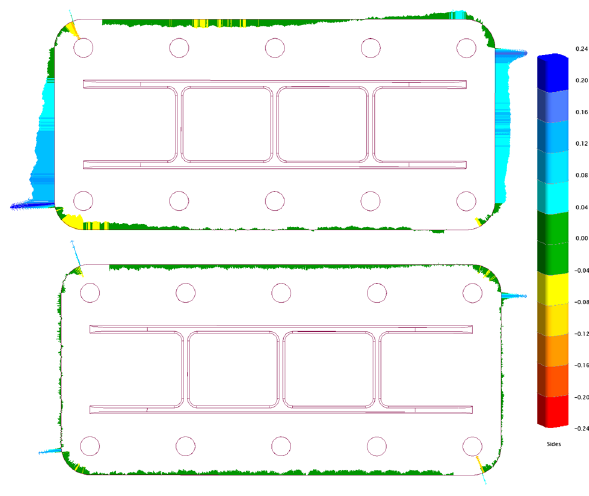
Figure 28. Comparison of measured periphery of the part vs. nominal CAD. ( top ) without feedback; ( bottom ) with feedback. Errors are indicated in mm. J. Manuf. Mater. Process. 2020 , 4 , x FOR PEER REVIEW 21 of 26